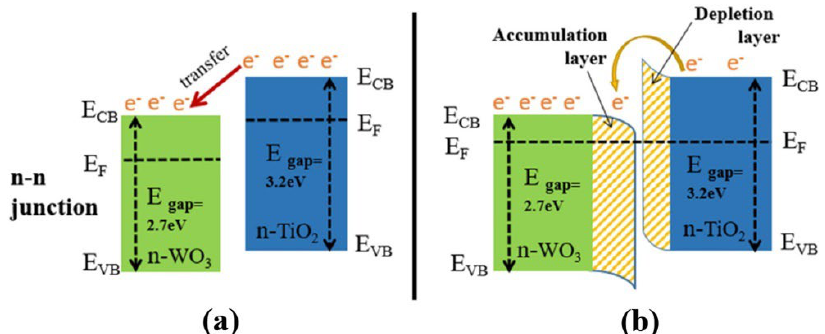
Figure 29. The formation of an n–n heterojunction at the interface between TiO 2 and WO 3 : ( a ) the directional transfer of electrons; and ( b ) the formation of an electron-depletion layer in TiO 2 and an electron-accumulation layer in WO 3 . Reprinted from [172].